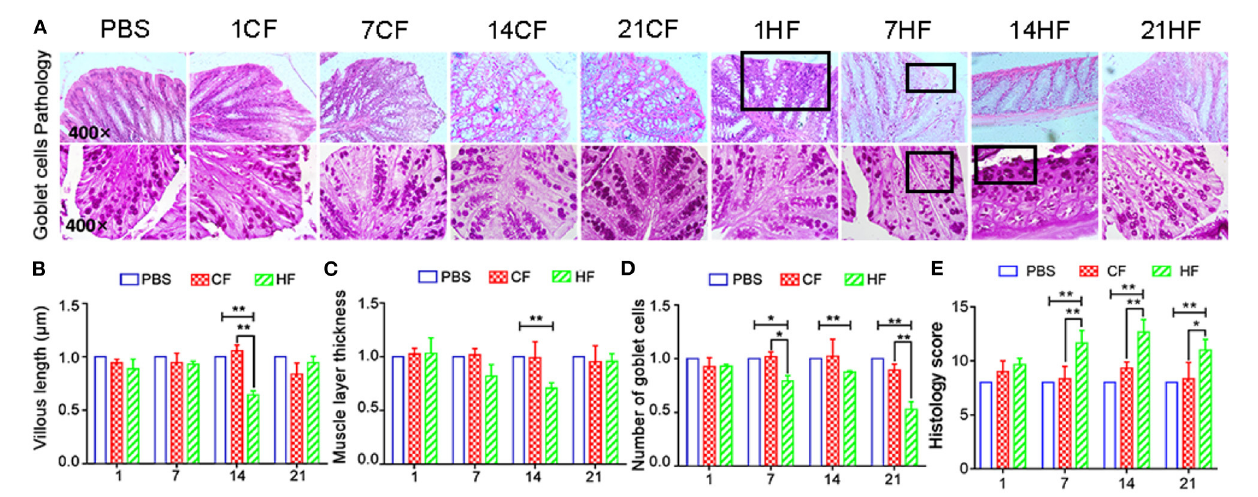
FIGURE 7 | Histopathology of colonic mucosa of mice following pig fecal microbial transplantation. (A) H&E and PAS staining; (B) colonic mucosal height; (C) colon muscle layer thickness; (D) number of PAS-positive goblet cells per mm 2 colonic mucosal; (E) Histology score of mice colon. CF & HF refer to mice administered with feces from control– and HS pigs respectively; 1, 7, 14, and 21 refer to sampling days of pig feces and mouse transplantation. * P < 0.05, ** P < 0.01 compared with each group.